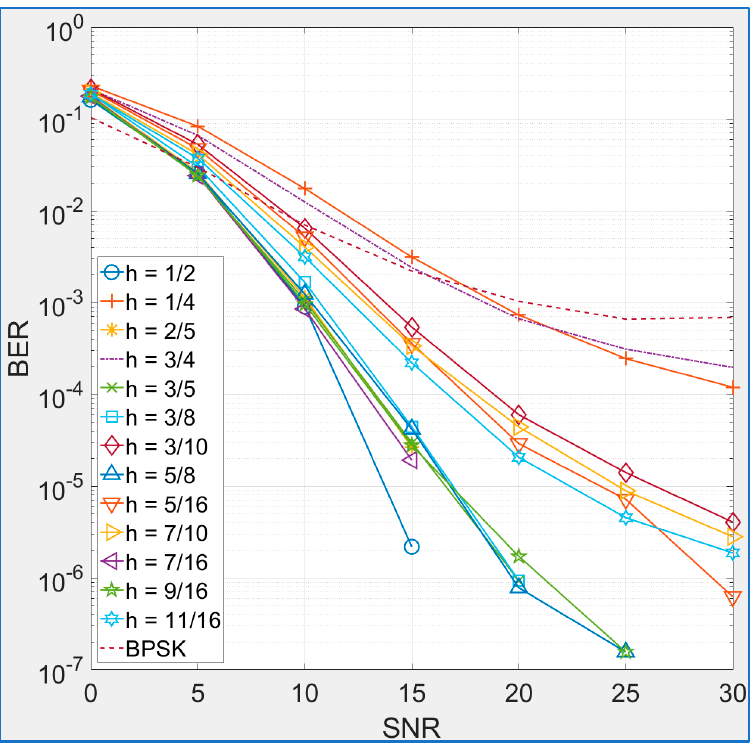
Figure 6. BER performance of binary CPM-GFDM vs. BPSK-GFDM for matched filter receiver over AWGN channels .